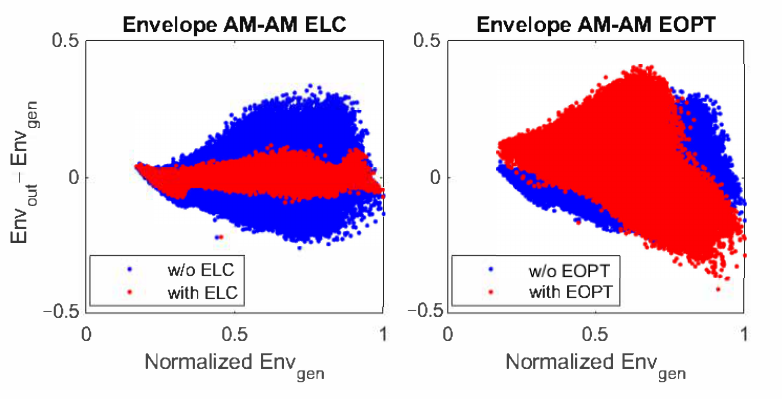
Figure 11. AM–AM plot of the normalized generated envelope ( Env gen ) and the ETM output envelope difference (i.e., Env out − Env gen ).